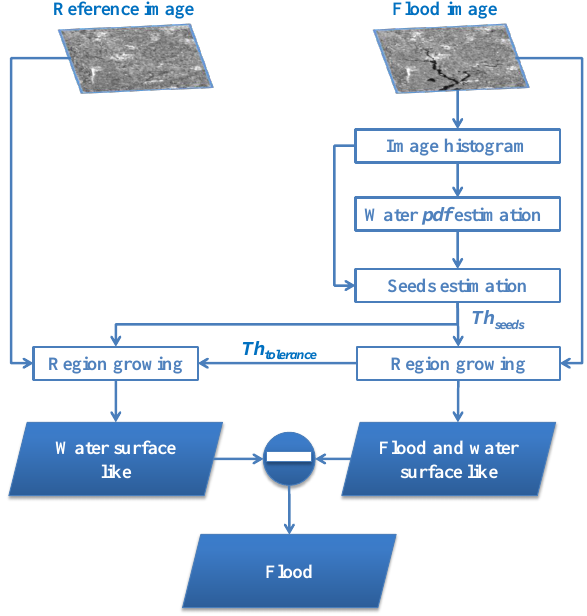
Figure 1. General scheme of the three processing steps of the flood detection